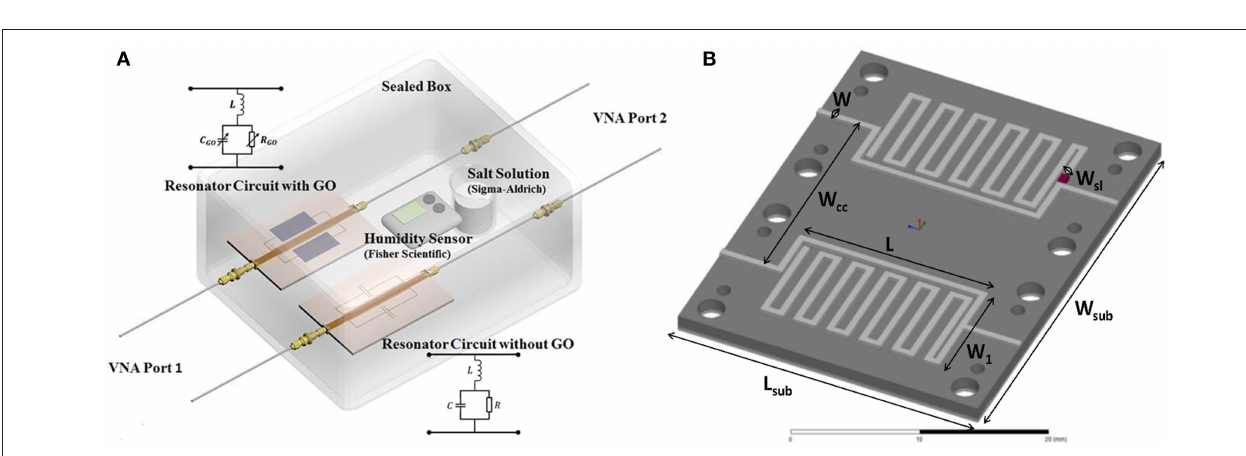
FIGURE 10 | (A) Separated sensitive resonator and reference resonator, (B) dimensions and geometry of differential sensor based on two stub resonators. Reproduced with permissions from Bahoumina et al. (2017) and Huang et al. (2018). Copyright 2017